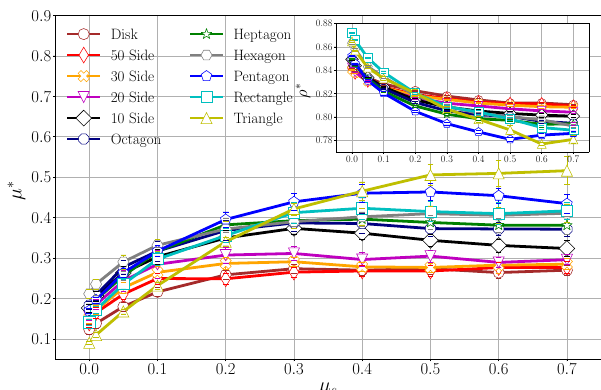
Figure 3. Macroscopic friction coe ffi cient µ ∗ and packing frac- tion ρ ∗ (inset) in the steady state, as functions of the contact fric- tion µ s . The error bars show the standard deviation in the steady state.